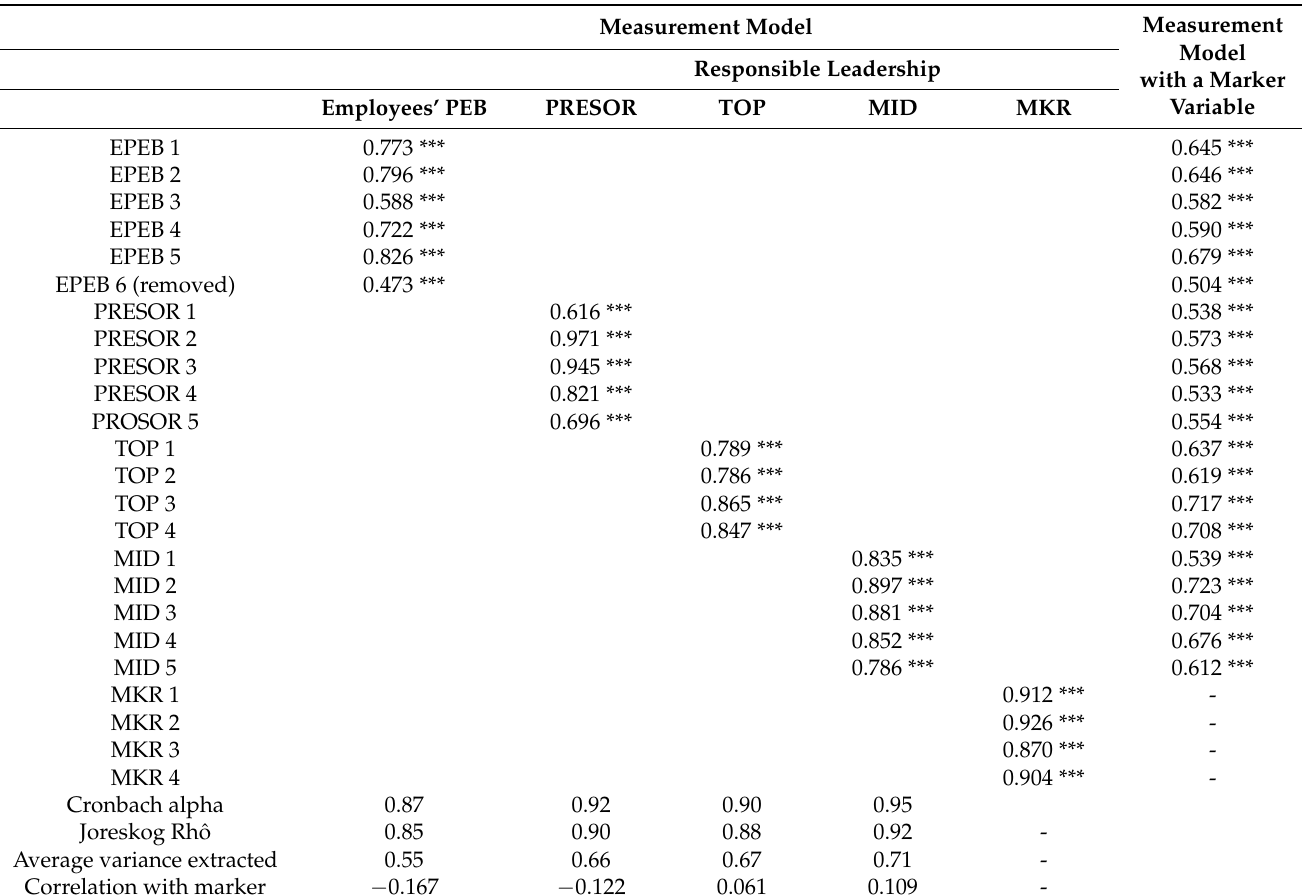
Table 1. Standardized parameter estimates for measurement model with and without marker.